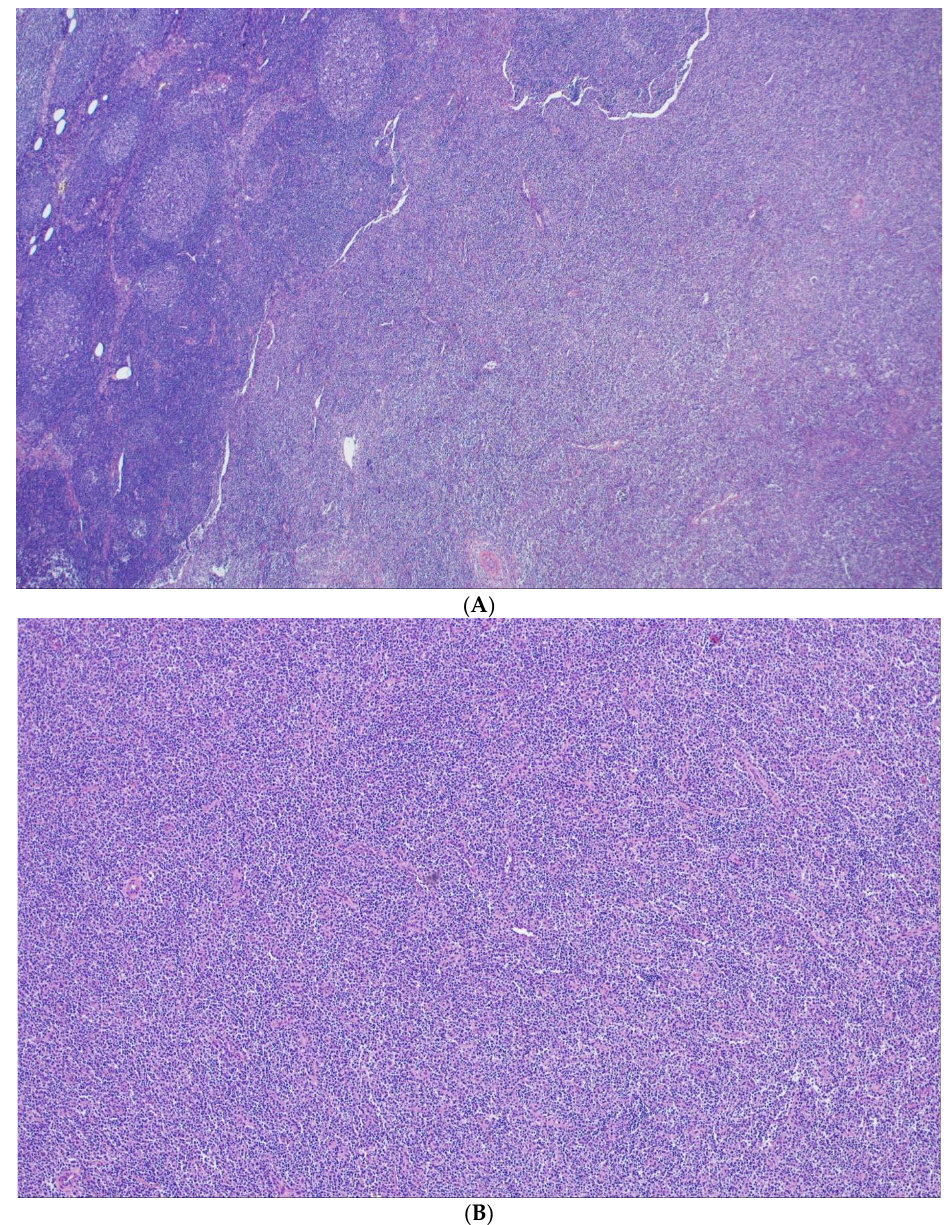
Figure 5. Predominantly diffuse FL. ( A ) Low magnification shows a preserved subcapsular rim of preserved reactive lymphatic tissue to the left and an ill-defined lymphomatous infiltration to the right (H&E × 40). ( B ) Higher magnification reveals an entirely diffuse growth pattern (H&E ×